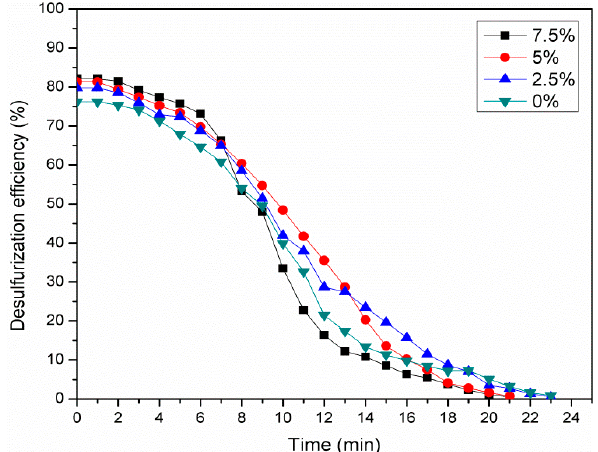
Figure 6. Effect of change in oxygen content on SO 2 adsorption behavior (operated at 60 °C, 4 g Figure 6. E ff ect of change in oxygen content on SO 2 adsorption behavior (operated at 60 ◦ C, 4 g sample, sample, 2000 ppm SO 2 , N 2 to balance, and 1 L/min total flow rate). 2000 ppm SO 2 , N 2 to balance, and 1 L / min total flow